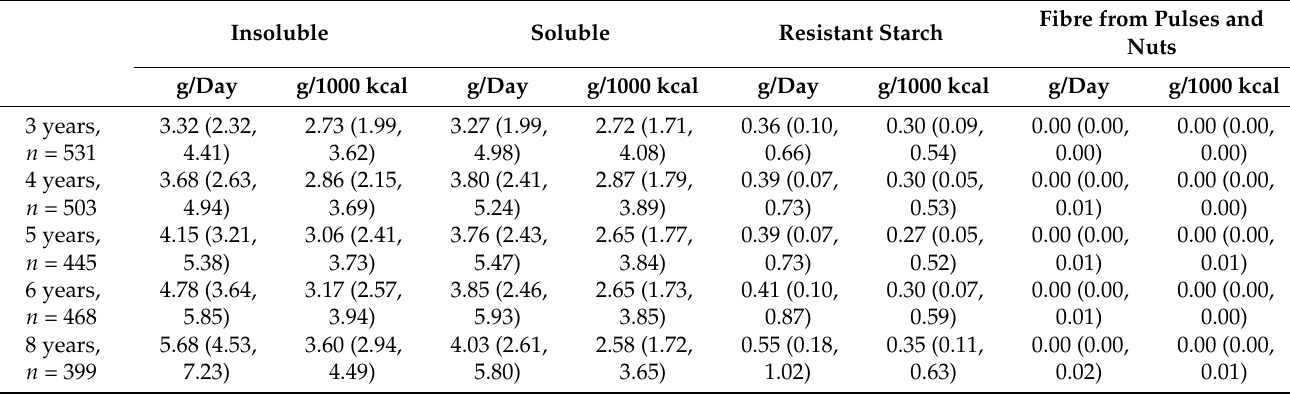
Table 2. Fibre intake by age according to food source.